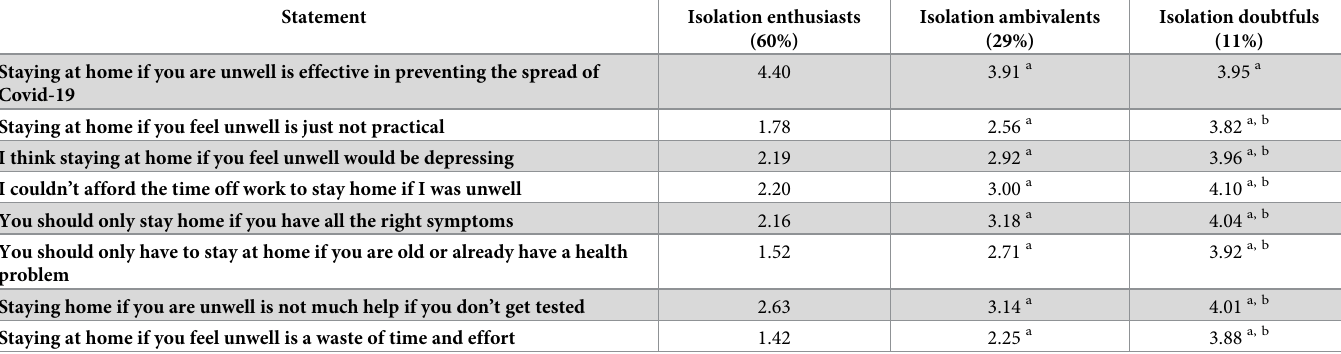
Table 8. Belief segments for